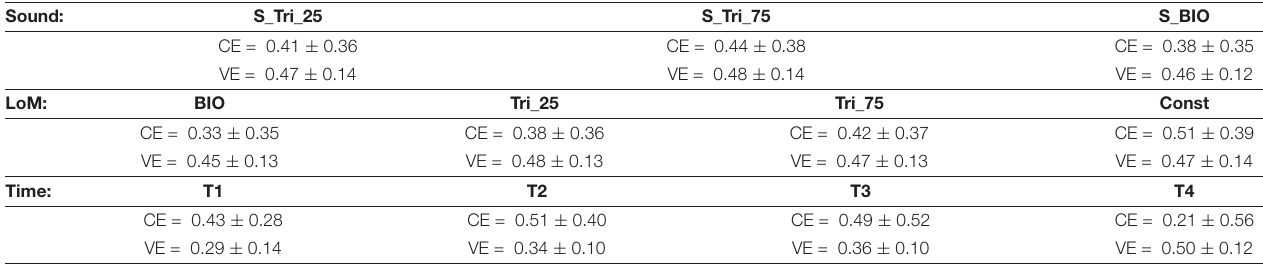
TABLE 3 | Results of Experiment 3 – Constant Error (CE) and Variable Error (VE) for the three main factors: Sound, Time and Law of Motion